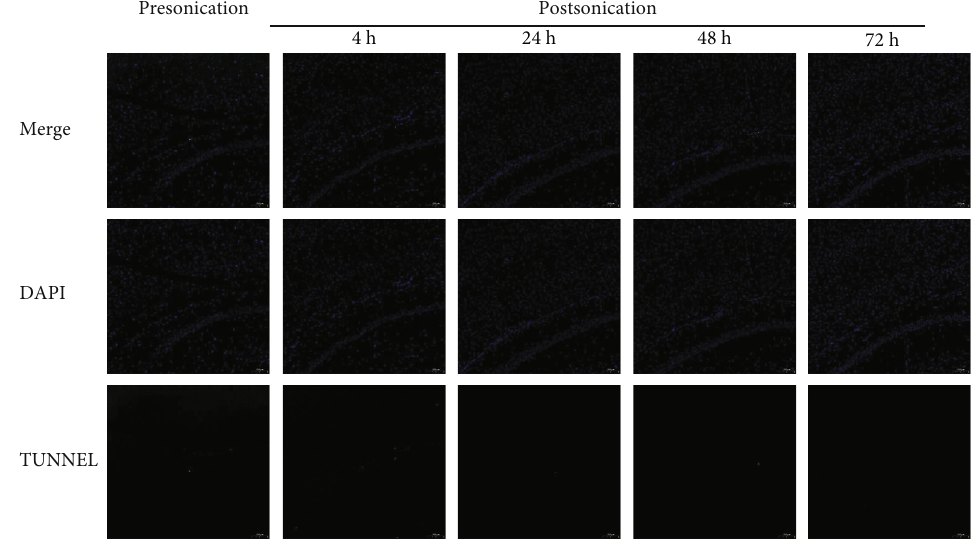
Figure 6: TUNNEL staining ( × 100, scale bar = 100 μ m) shows that there is no signi fi cant apoptosis at 4, 24, 48, and 72h postsonication compared with presonication.